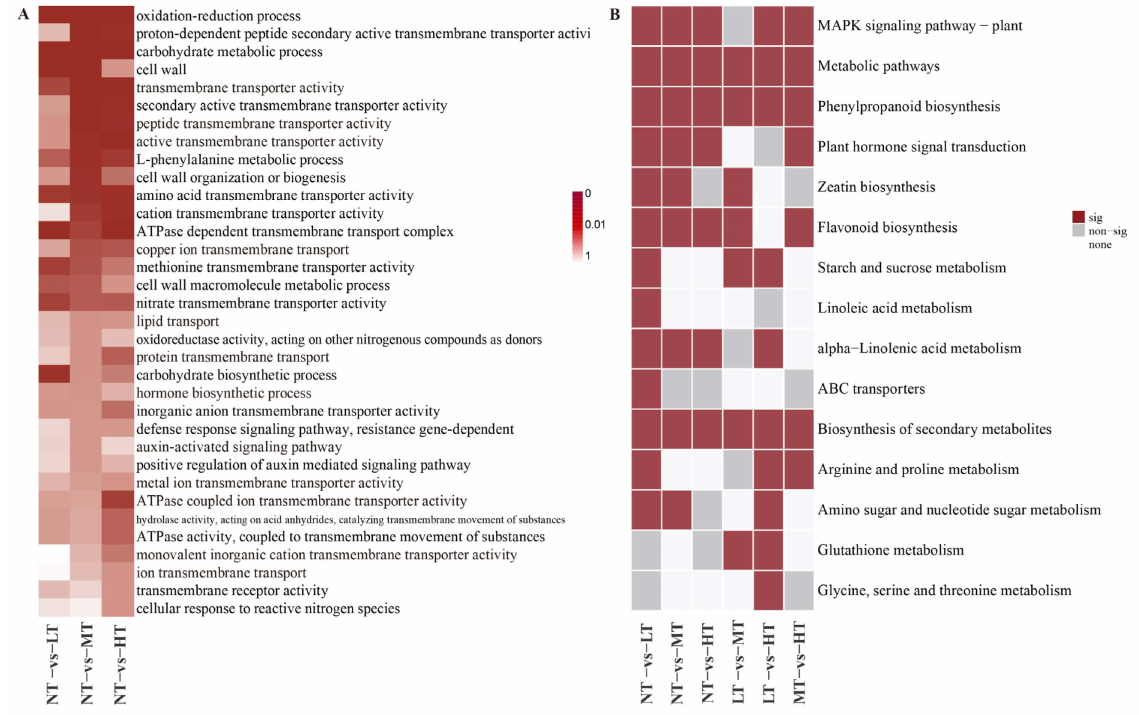
Figure 3. ( A ) Gene Ontology (GO) terms for the primary biological processes of the paclobutrazol re- sponsive transcripts in the roots under different PBZ concentrations (false discovery rate (FDR) < 0.05). The plant hormones processes highlighted by blue words are those with higher enrichment under MT conditions than under other conditions. ( B ) Summary of the key KEGG pathways that are significantly enriched by various differentially expressed gene sets (false discovery rate (FDR) < 0.05). NT, LT, MT, and HT represent the control and three treatment groups,